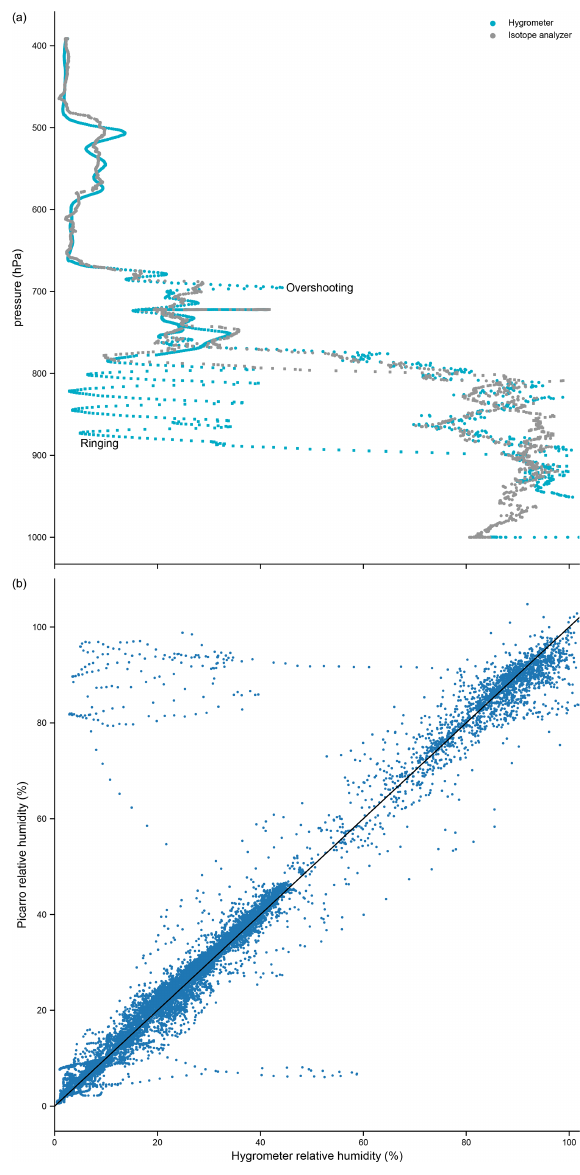
Figure 3. (a) Vertical profiles of relative humidity from the P3 hygrometer (teal) on 19 January 2020 show overshooting, ring- ing, and a slow time response under the low-humidity conditions found at the highest flight altitudes. These features are absent in the relative humidity profiles estimated from the water vapor iso- topic analyzer (grey). Data in this panel are taken in two time win- dows (15:36:00 to 16:07:40UTC, shown as circles, and 20:31:12 to 20:41:16UTC, shown in squares) encompassing two separate slow profiles. (b) Relative humidity as measured by the two sensors over the entire flight. The black line indicates equality. There is good agreement between the two water vapor sensors when relative hu- midity exceeds ∼ 20% and when the hygrometer is not ringing or